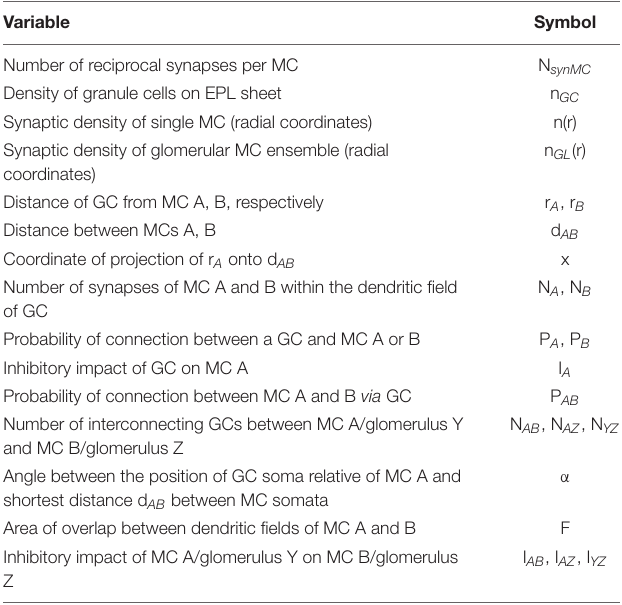
TABLE 2 | Additional important variables and their